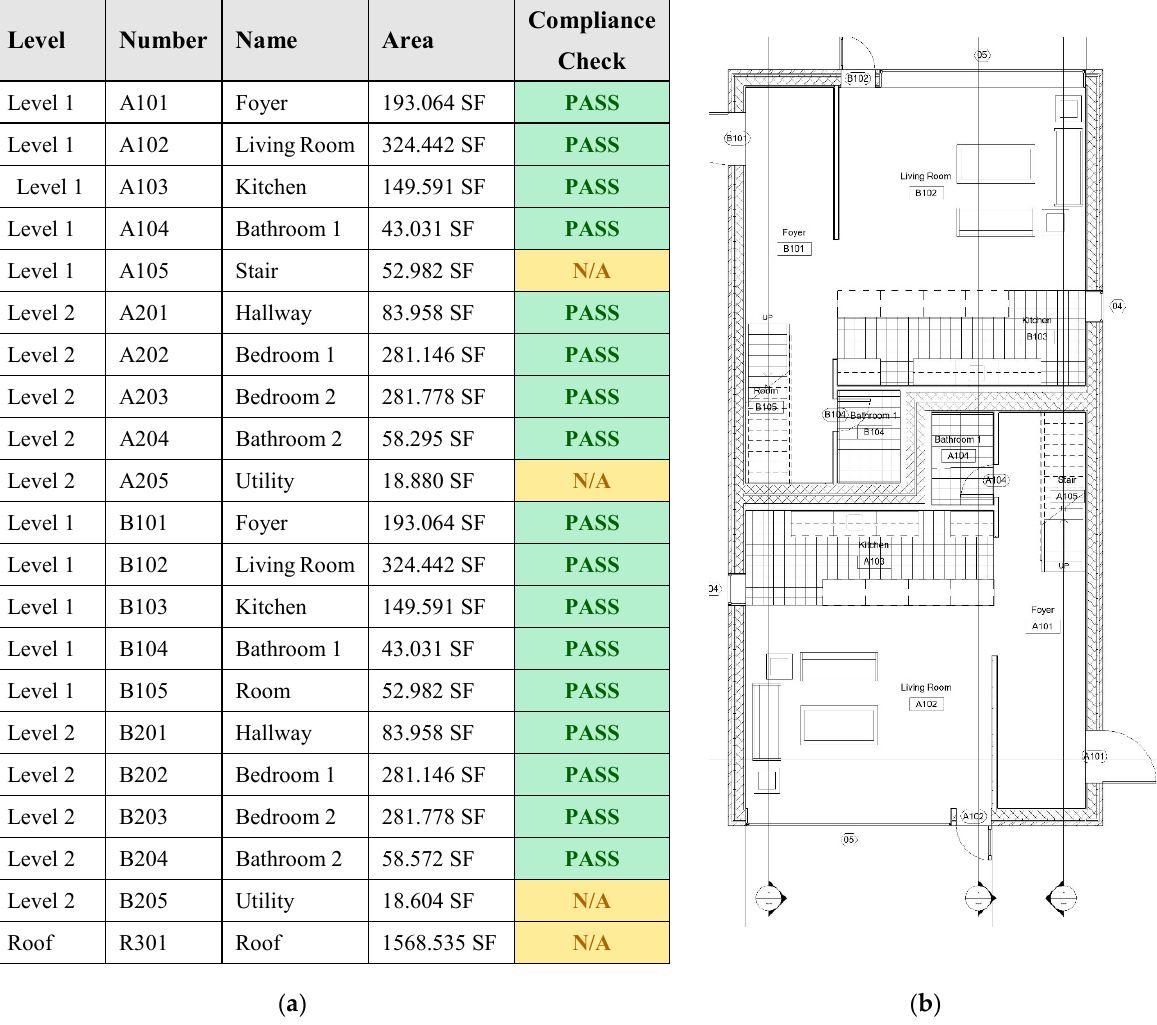
Figure 11. A part of the implementation algorithm.